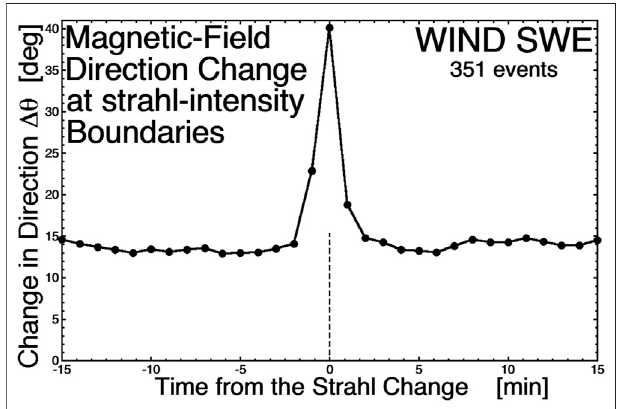
FIGURE 12 | The superposed epoch average of the temporal change in the magnetic- fi eld direction is plotted for 351 strahl-intensity boundary crossings measured by WIND at 1